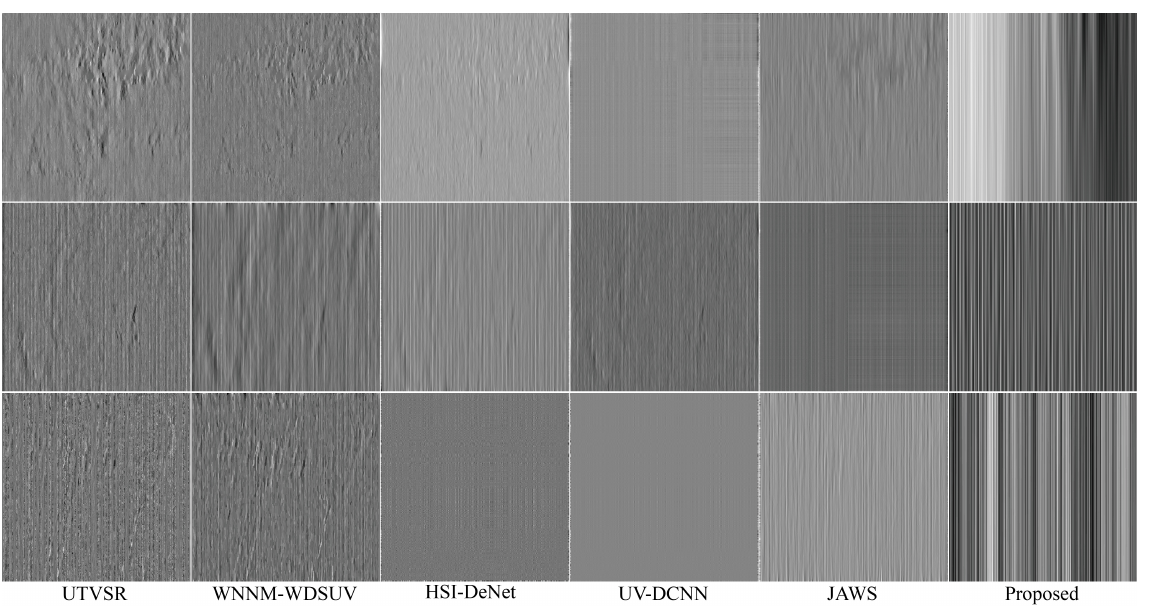
Figure 14. Visual comparisons of the estimated stripes corresponding to the RAM1 , RTM1 , and Hy- perspectral urban images in Figure 13. Table 4. Quantitative comparisons of the state-of-the-arts on the real-life optical RSIs shown in Figure